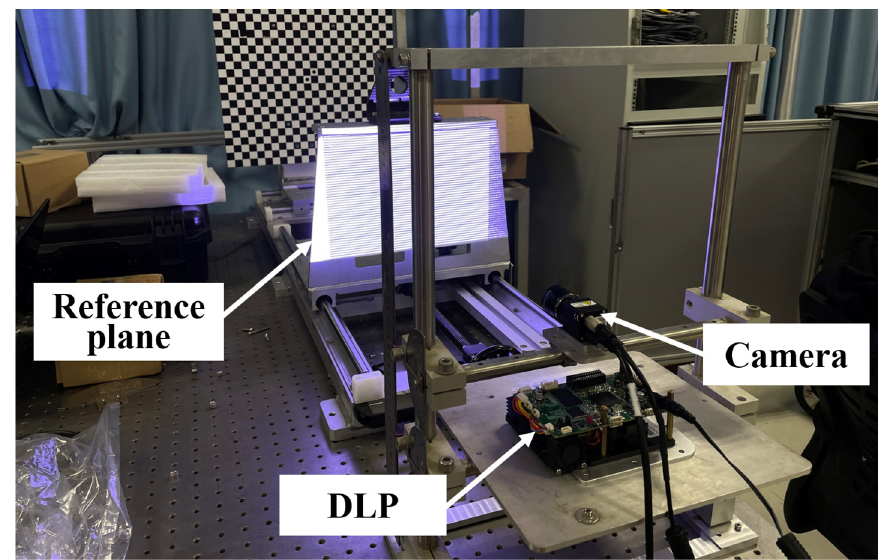
Figure 13. Calibration platform.